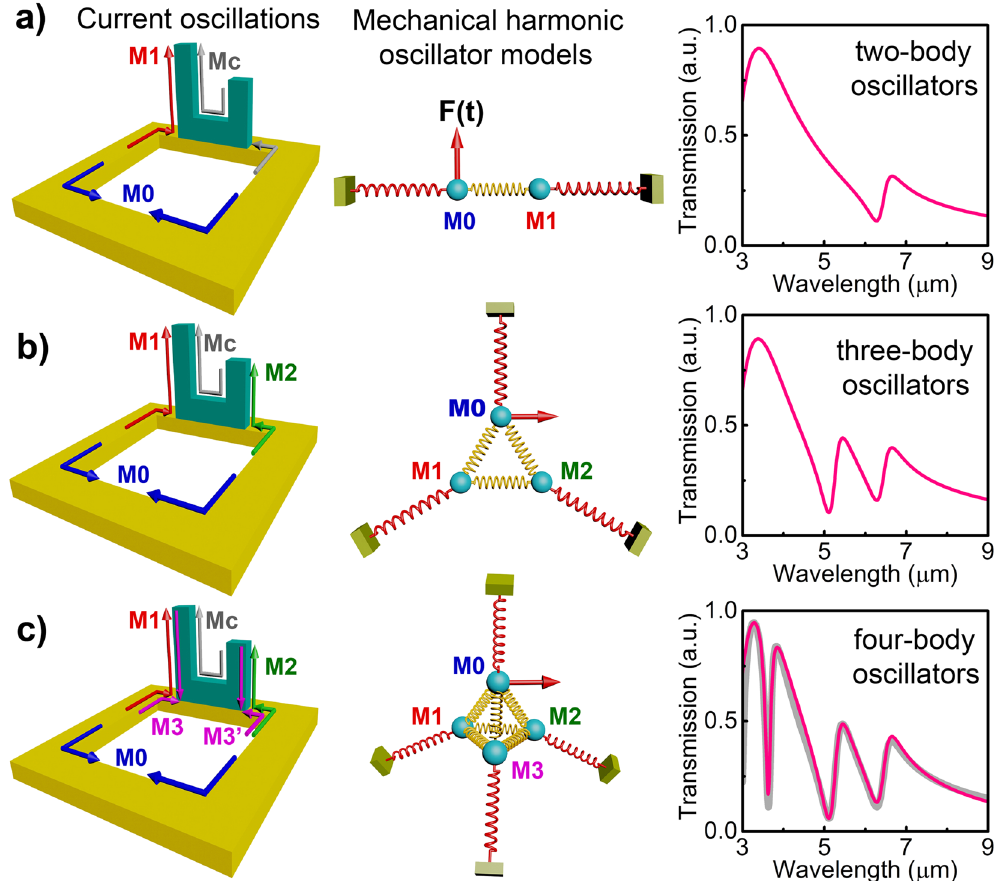
Figure 3. Oscillator modeling. (left) Schematic plots of the oscillating currents under different resonant mode couplings, (center) the mechanical harmonic oscillator models, and (right) the analytically calculated transmission of the 3D structure with arm height of H Arm1 = 1.2 µ m and H Arm2 = 0.8 µ m, in the models of ( a ) two-body oscillators, ( b ) three-body oscillators, and ( c ) four-body oscillators, respectively. The circular current flows (Mc) in the left column provide an interaction channel to mediate the charge density along the two arms. The grey spectra in Fig. 3c represents the plot of the numerical result in Fig. 2b, which is well consistent with the analytical calculation. In all three models, k 12 = k 13 = k 23 = 0 is used since in this structure, the Fano resonances are far away from the anticrossing regions and therefore not coupled. Other coupling coefficients are employed as in Supplementary Section II. Structural parameters are the same as in Fig. 2. From these models, it can be seen that Fano resonances F1, F2 and F3 result from the M0-M1 (interference between modes M0 and M1), M0-M2, and M0-M3 interferences, respectively (Supplementary Fig.